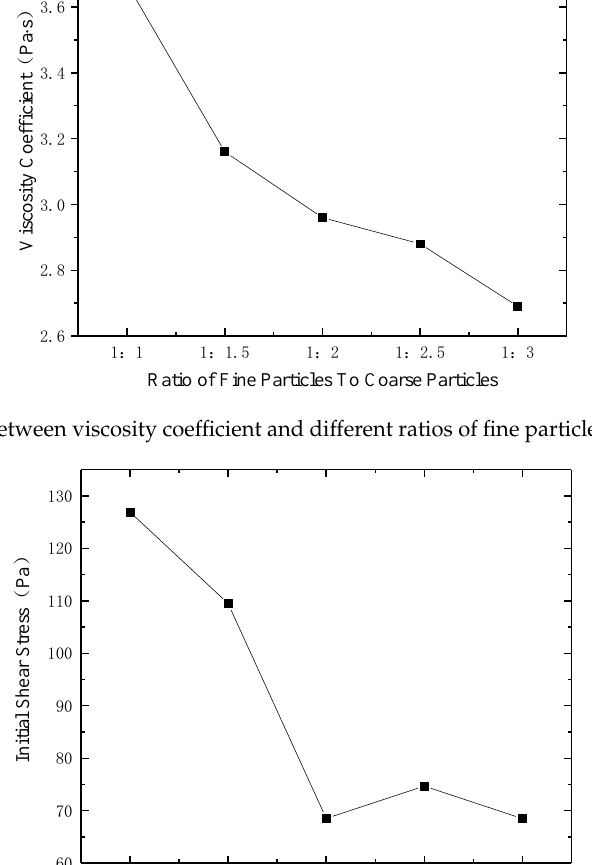
Figure 11. Relation between viscosity coefficient and different ratios of fine particles to coarse particles.